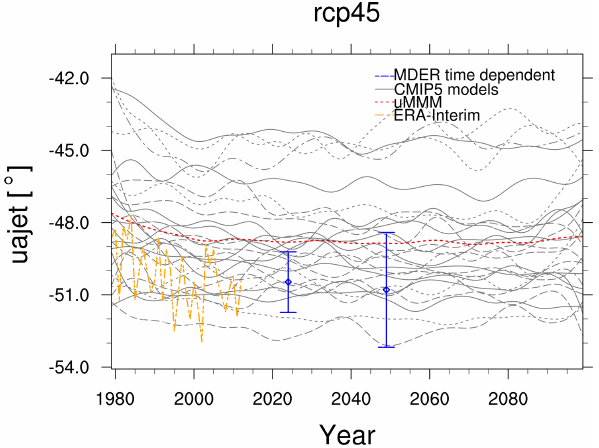
Figure 15. Time series of the austral jet position for the RCP4.5 sce- nario between 1980 and 2100 based on Wenzel et al. (2016b). The gray lines show individual CMIP5 models and the dotted red line the unweighted CMIP5 multi-model mean (uMMM). Observationally based estimates of the jet position from ERA-Interim (Dee et al., 2011) are represented by the dashed yellow line. Blue error bars in- dicate the predicted jet position by the MDER analysis (multiple di- agnostic ensemble regression) for the near-term future (2015–2034) and the midterm future (2040–2059). Similar to Fig. 5 of Wenzel et al. (2016b) and produced with recipe_wenzel16jclim.yml ; see de- tails in Sect.